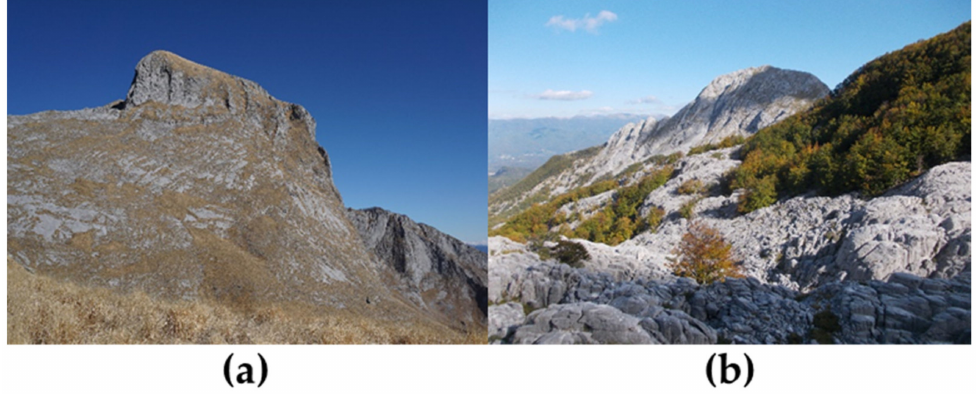
Figure 1. ( a ) Marble outcrops with a low development of epikarst and a low infiltration rate (M. Sumbra); ( b ) Marble outcrops with a well-developed epikarst and a high infiltration rate (Panie group). Both areas belong to the catchment area of the Pollaccia